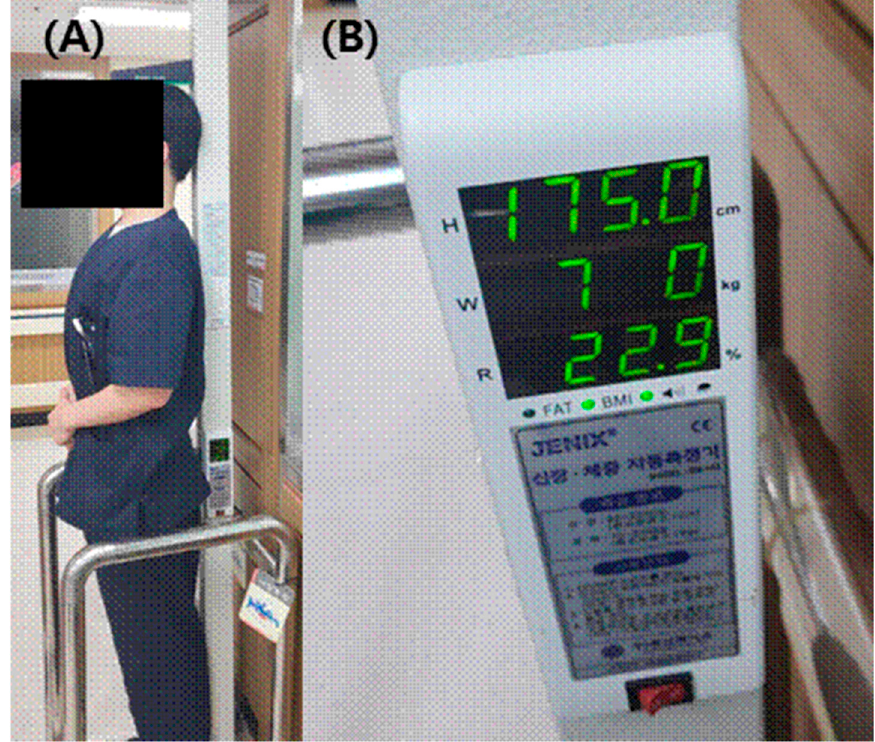
Figure 1. ( A ) Subjects stand upright in an anatomical position for measuring height. ( B ) The subject’s living height was measured by using the standard height measurement scale taken in centimeters (cm) (with one decimal place).